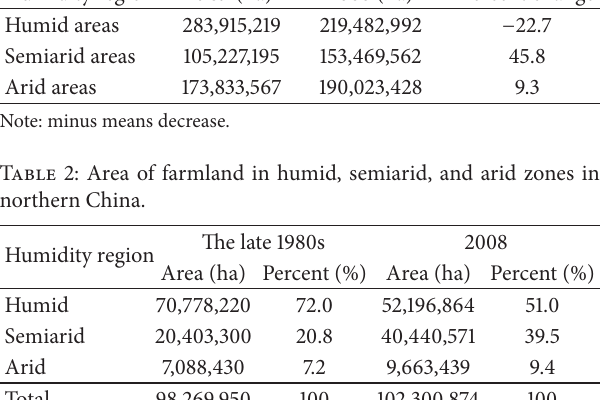
Table 1: Area of humid, semiarid, and arid zones in northern China. Humidity region